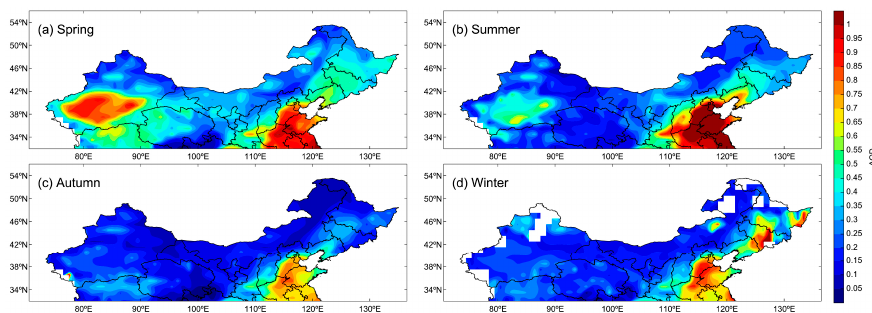
Figure 4. Seasonal mean AOD over North China in ( a ) spring, ( b ) summer, ( c ) autumn, and ( d ) winter, for the period 2001–2016. for the period